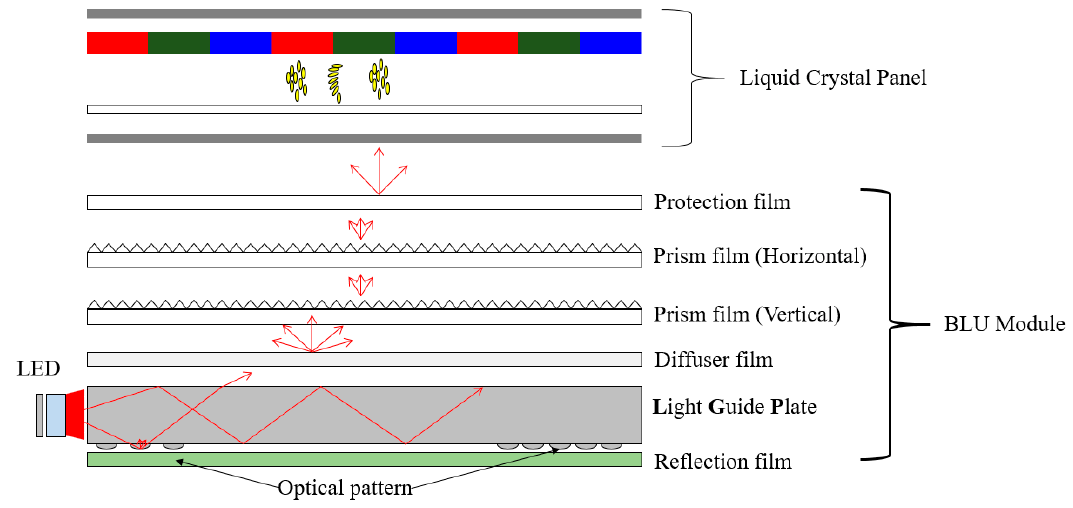
Figure 1. The structure of a backlight unit (BLU).